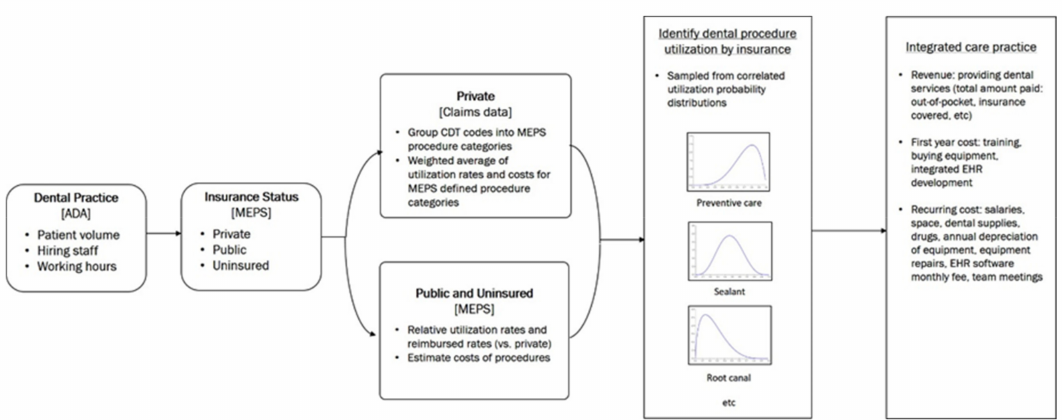
Figure 1. Simulation model flow diagram [data sources]. ADA = American Dental Association; MEPS = Medical Expenditure Panel Survey; CDT = Code on Dental Procedures and Nomenclature.